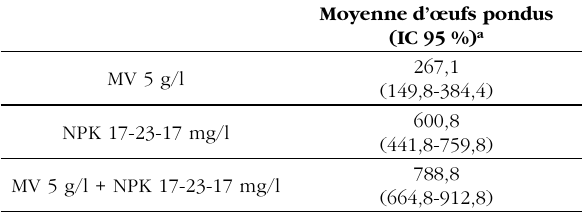
tableau i. – moyennes d’œufs pondus (12 lots de 15 femelles de Aedes aegypti répartis sur les prélèvements de J des eaux qui contenaient de la matière végétale (mV), de l’engrais nPK et un mélange des deux substrats